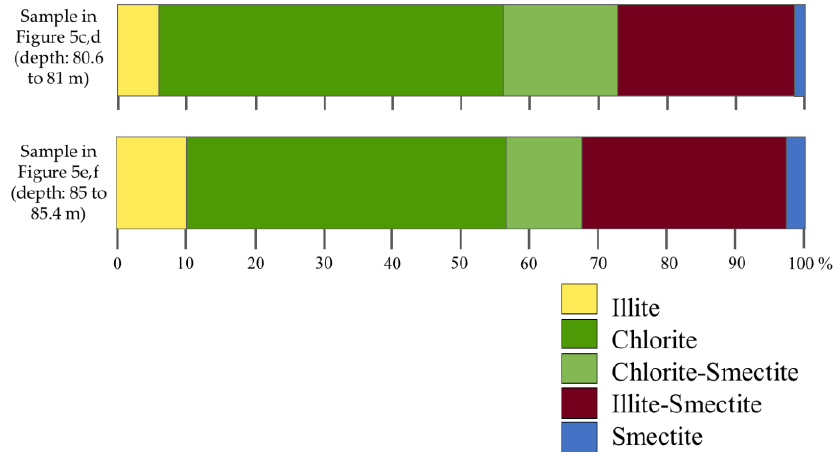
Figure 7. Results of mixed-layer clay classification for samples in Figure 5c,d (depth: 80.6 to 81 m) and in Figure 5e,f (depth: 85 to 85.4 m).